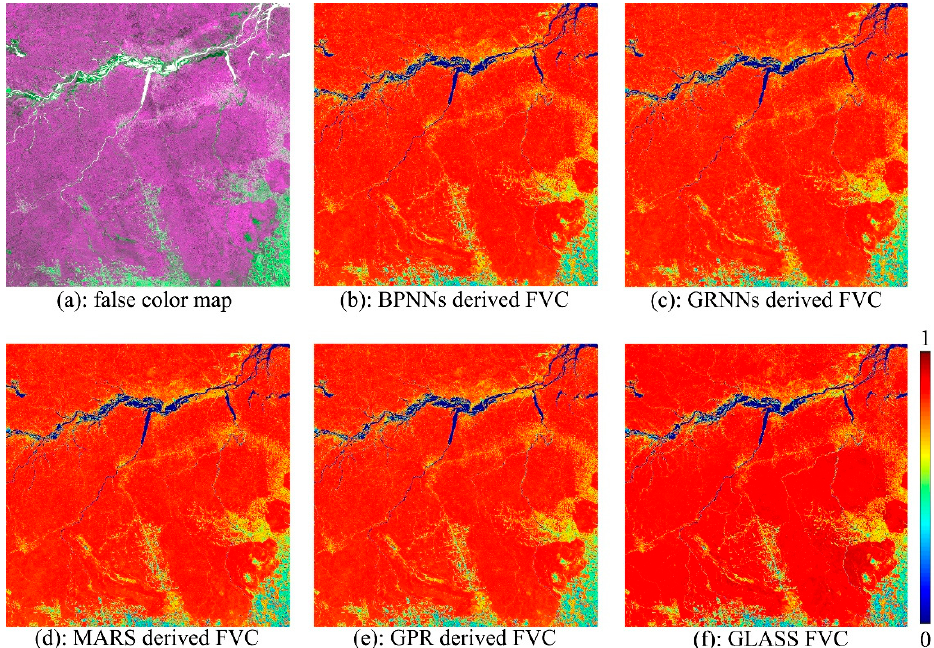
Figure 7. The false color map of the VIIRS data and FVC maps derived from the four machine learning methods, as well as GLASS FVC product: ( a ) False color map of VIIRS reflectance data (R, G and B channels with VIIRS reflectance of NIR, Red and short-wave infrared (SWIR) bands, respectively); ( b ) back propagating neural networks (BPNNs); ( c ) general regression networks (GRNNs); ( d ) MARS; ( e ) Gaussian process regression (GPR) and ( f ) GLASS FVC.